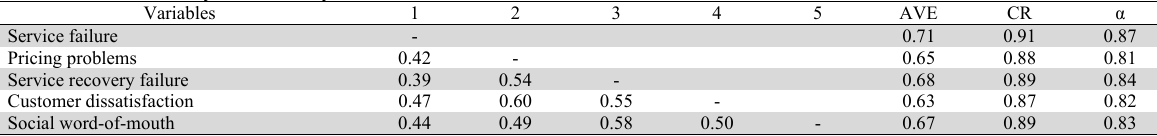
Correlations, reliability and validity results